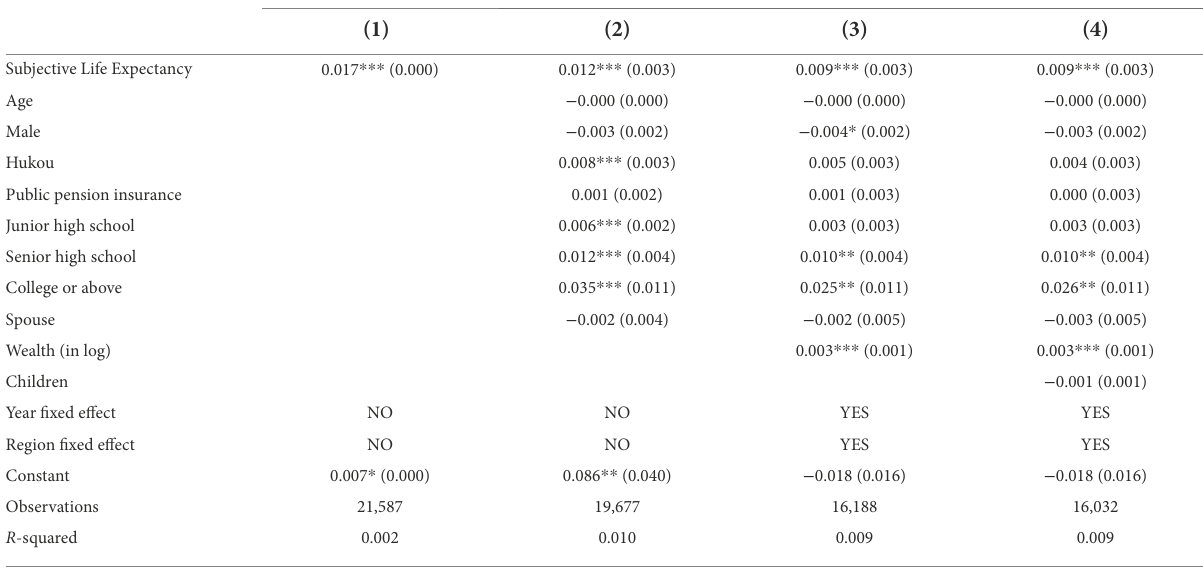
TABLE 2 Effect of subjective life expectancy on commercial pension insurance participation.